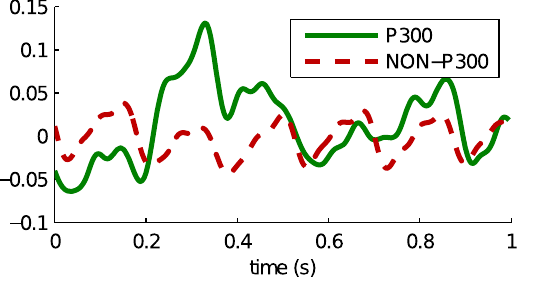
Figure 1. Plot showing the average P300 response versus the average background EEG.